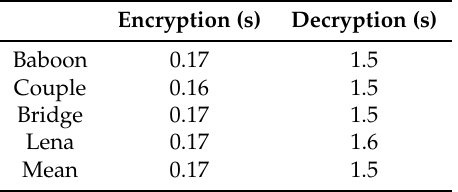
Table 6. Time consumption of the encryption and decryption process for the proposed method.